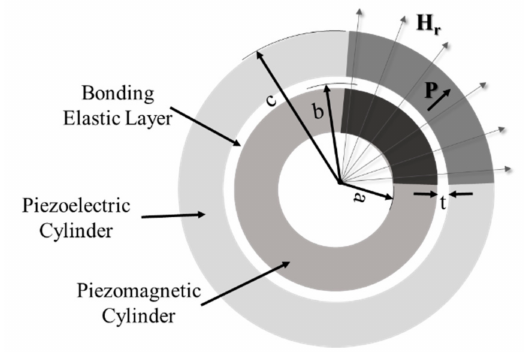
Figure 1. Schematic of the geometry of the considered boundary-value